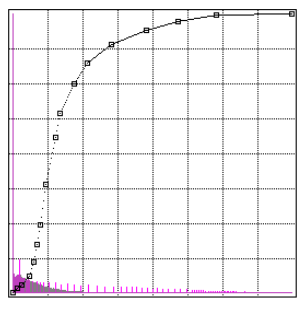
Figure 3. Heat map histogram specification